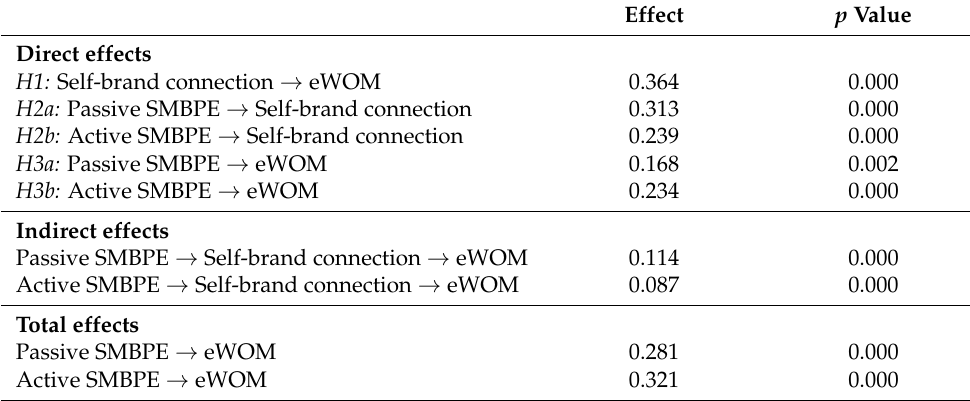
Table 4. Structural model